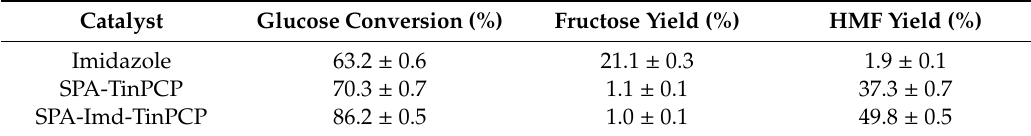
Table 1. Conversion of glucose to HMF with various catalysts.